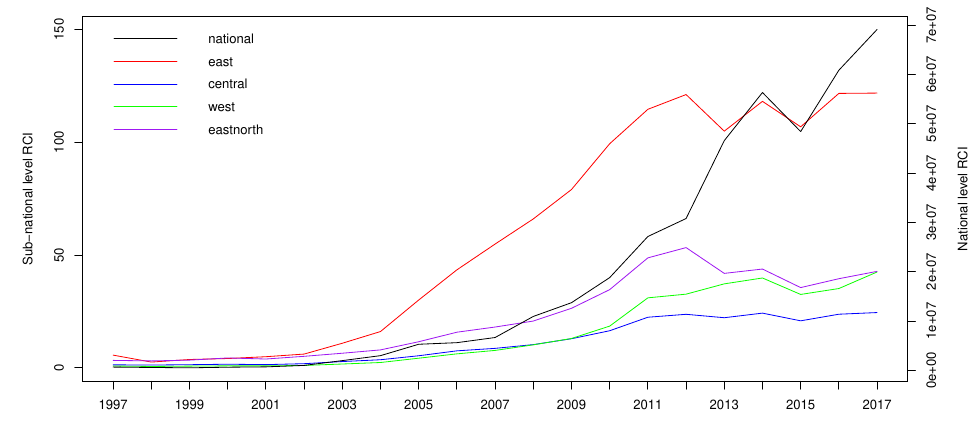
Figure 1. The national and sub-national levels RCI indexes estimation results of original carbon emission data for the nation and the east, central, west, and northeast four regions in China from 1997 to 2017. Refer to the primary axis ( left side ) for the sub-national level RCI scales. Refer to the secondary axis ( right side ) for the national level RCI